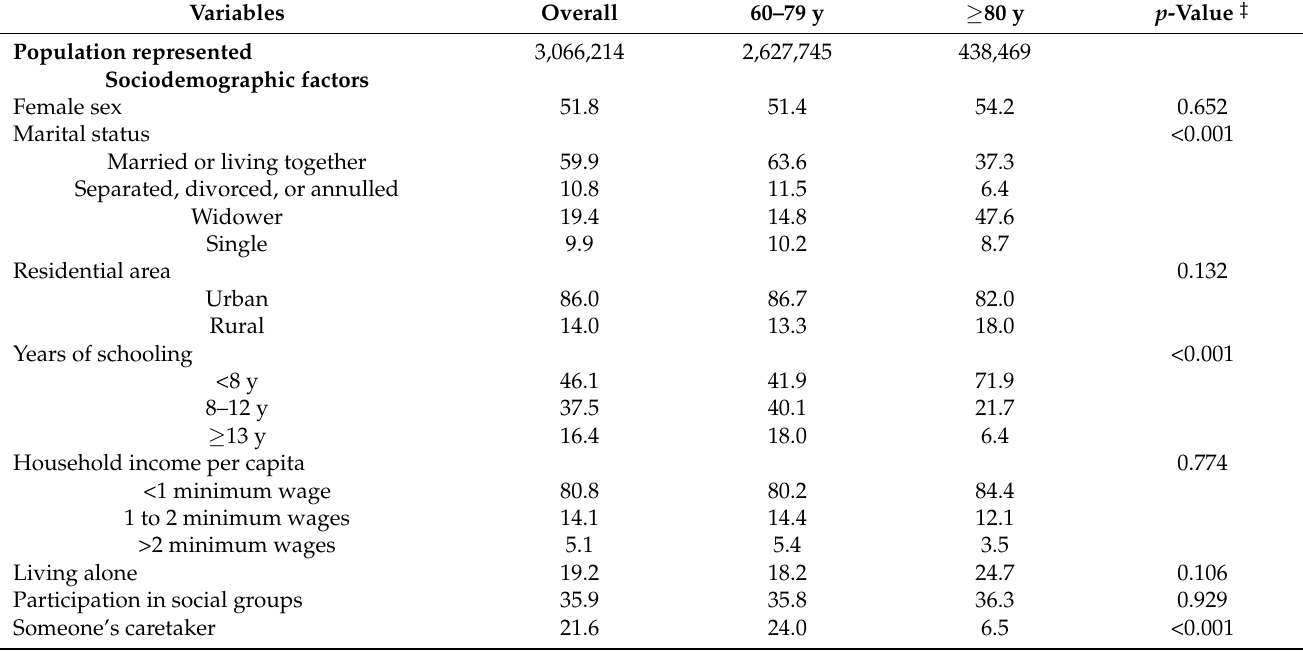
Table 1. Description of sociodemographic and health-related indicators of the sample by age